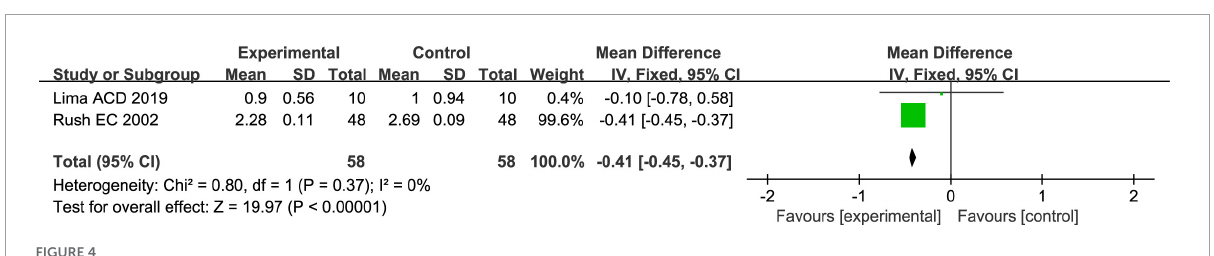
FIGURE4 Effect of fruit intervention on stool consistency in the fixed-effect